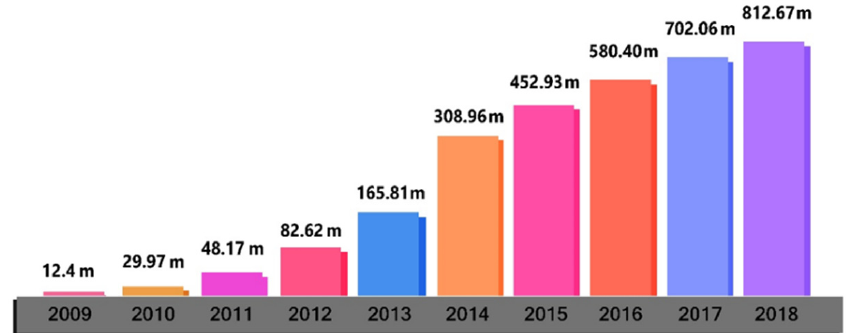
Figure 1. The ratio of malware from 2009 to 2018 (in millions).